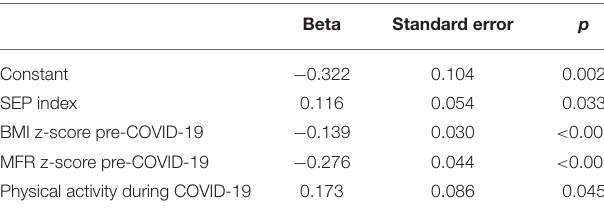
TABLE 4 | Linear regression model for delta muscle-to-fat ratio